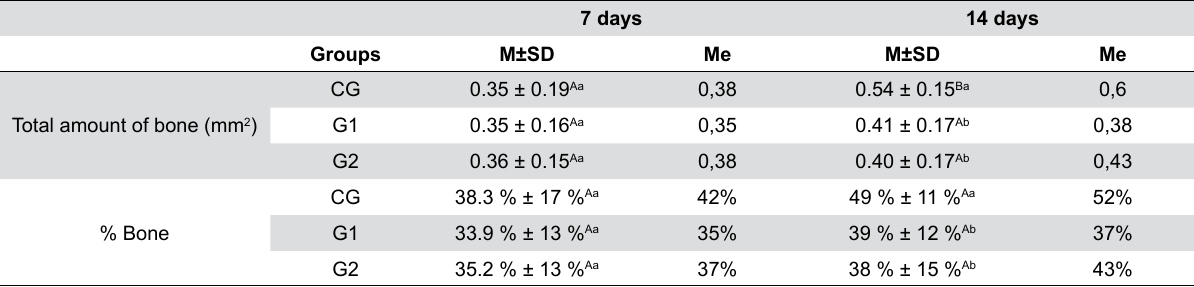
Table 3- Histomorphometric measurements of the delineated geometric area in mm 2